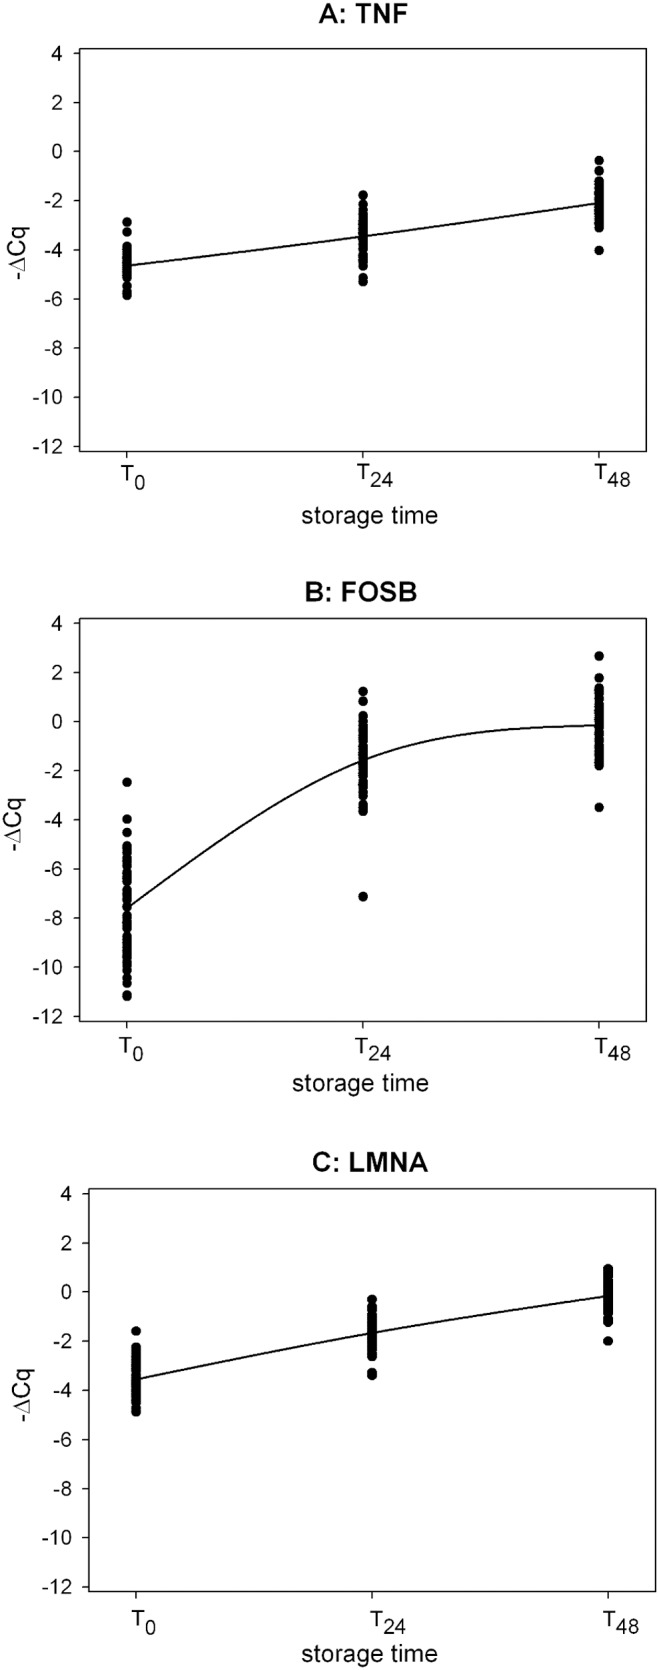
Time-course profile of EDTA up-regulation biomarkers in the validation study.2A: TFN_S (mixed model contrasts: T24 vs T0, p-value <0.0001; T48 vs T0, p-value <0.0001); 2B: FOSB_S (mixed model contrasts: T24 vs T0, p-value <0.0001; T48 vs T0, p-value <0.0001); 2C: LMNA_S (mixed model contrasts: T24 vs T0, p-value <0.0001; T24s vs T0, p-value <0.0001). ΔCq = (Cqbiomarker – Cqmeanref).